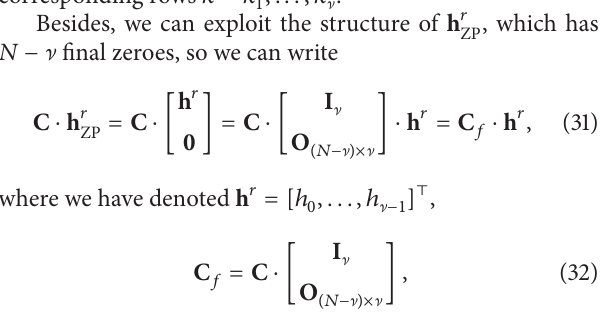
Figure 3: Channel reconstruction SNR ( the signal power to noise ratio (SNR ( dB ) ). The length of the channel is 𝐿 = 7 , the length of the DCT1 is 𝑁 = 256 , and 𝑁 𝑠 = 2000 simulations have been